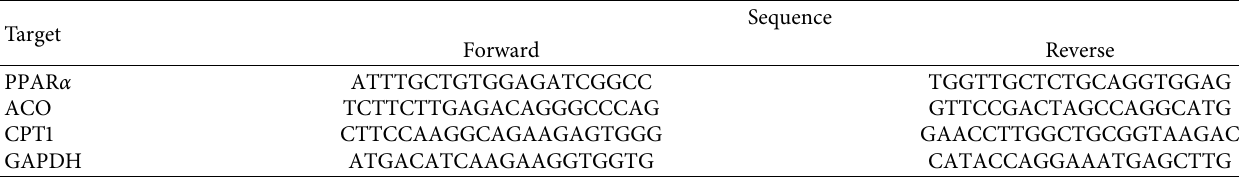
Table 1: Primer pair sequences used for real-time PCR.